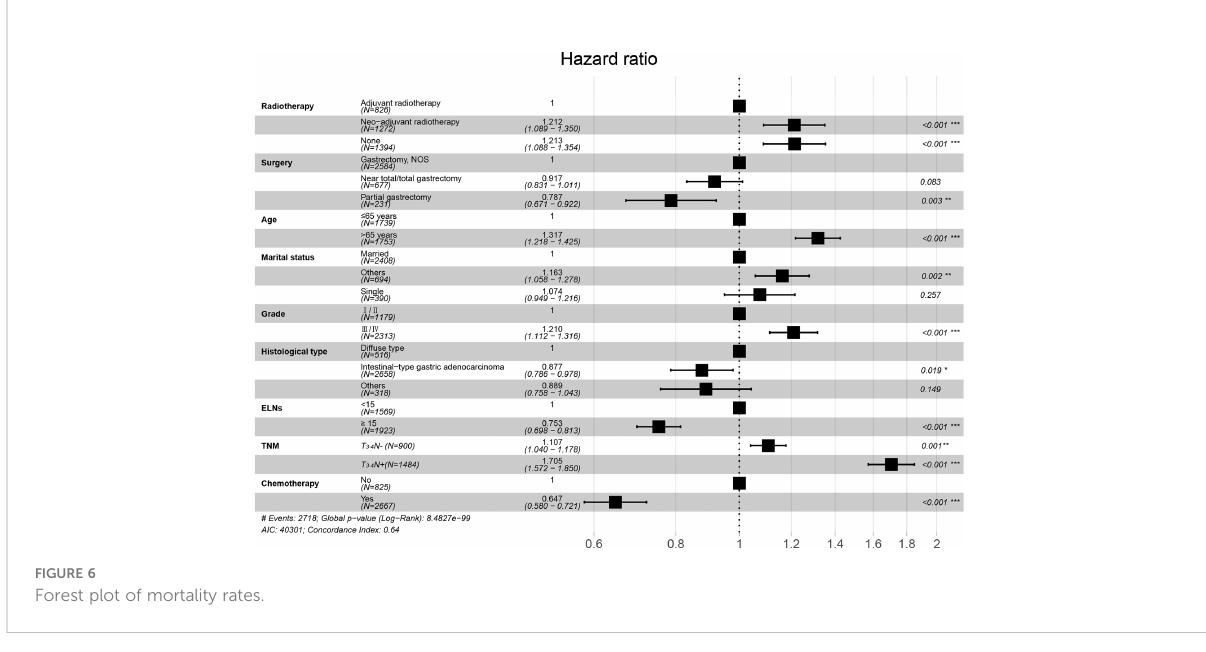
FIGURE 6 Forest plot of mortality